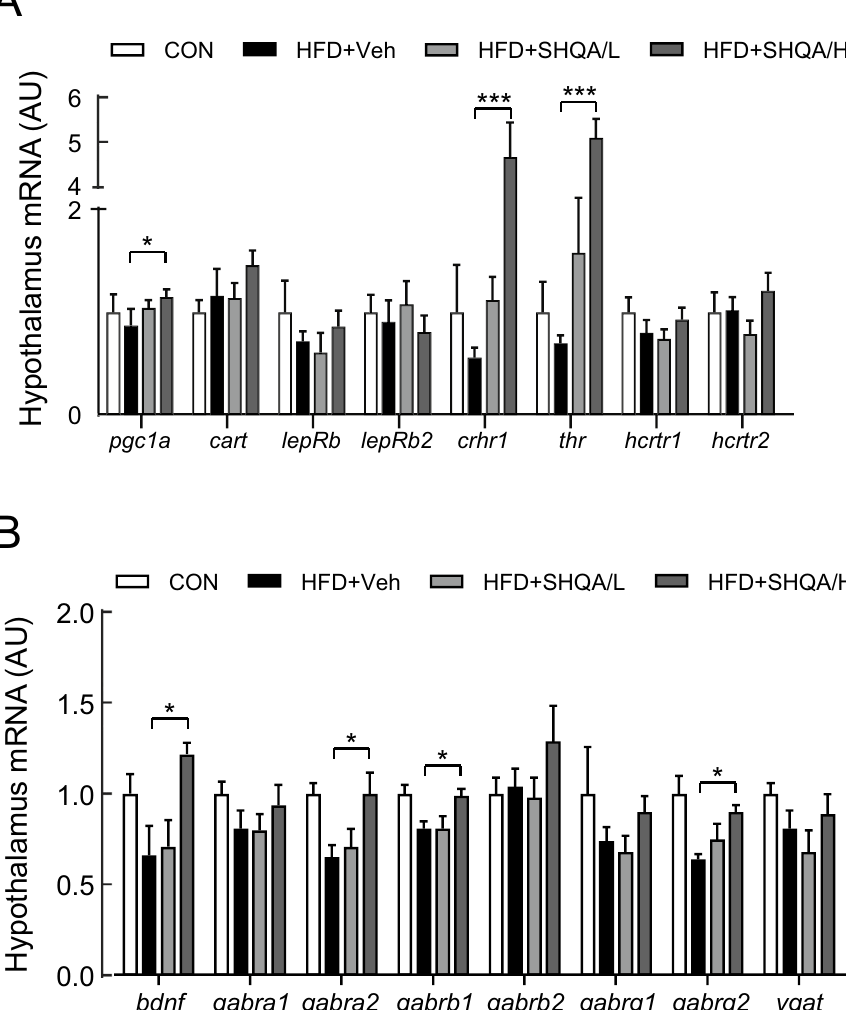
Figure 7. SHQA injection alters gene expression profile in the hypothalamus. C57BL/6 mice (4 weeks old) were fed a chow diet (CON) or a HFD with the hypothalamic injection of PBS (CON or HFD + Veh, three times a week), a low dose (HFD + SHQA/L, 20 ng/µl, three times a week) or a high dose of SHQA (HFD + SHQA/H, 100 ng/µl, three times a week) for 12 weeks. The hypothalamus from these mice was collected for measurements of mRNA levels. mRNA expression levels of genes related to ( A ) sympathetic outflow and ( B ) GABAnergic signaling pathways were measured in the hypothalamus of 12 wk-old mice fed a chow diet or HFD with or without SHQA injection. Data are expressed as mean ± S.E.M. (n = 6–7). Statistical differences between CON, HFD + Veh, HFD + SHQA/L, and HFD + SHQA/H were determined using one-way ANOVA followed by Tukey’s post hoc test: * p < 0.05, *** p <